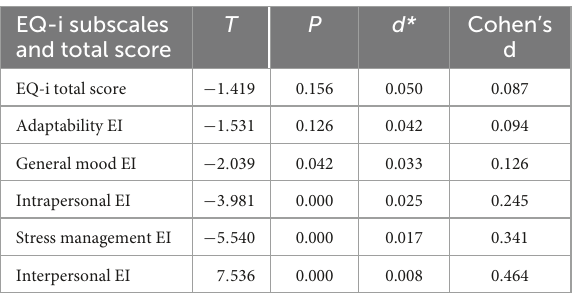
TABLE 4 Multiple t -tests (two tails) with corresponding p -values for testing gender differences between the EQ-i dimensions and total EQ-i score.